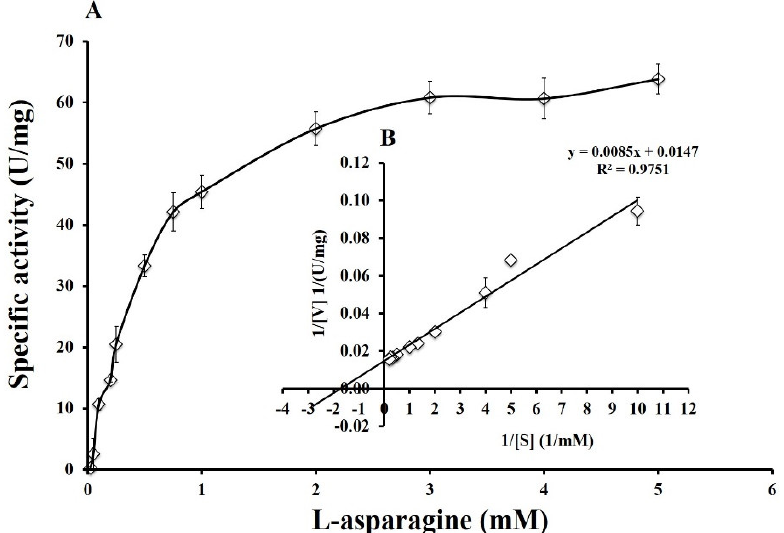
Figure 6. Kinetic study of His-tagged Pg -ASNase II. ( A ) Effect of varying L-asparagine concentration (0.10–5.0 mM) on Pg -ASNase II activity. ( B ) Lineweaver-Burk plot for determining a kinetic parameter of Pg -ASNase II for L-asparagine. The error bar represents the standard error of three experi- ments.